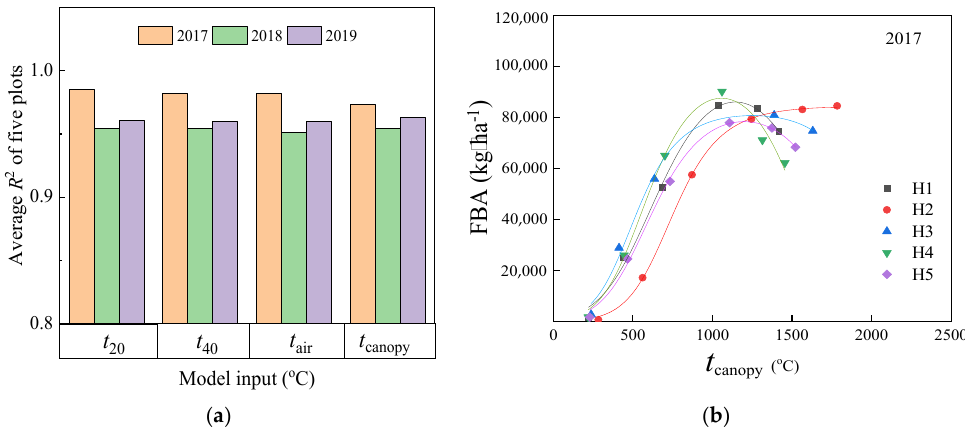
Figure 12. The performance of the FBA simulation results based on the R-logistic models. ( a ) Average R 2 values of FBA simulating at five plots based on the R-logistic model with four kinds of effective accumulated temperature in 2017–2019; ( b ) FBA simulating in five plots based on the R-logistic model with effective accumulated canopy temperature ( t canopy ) in 2017.